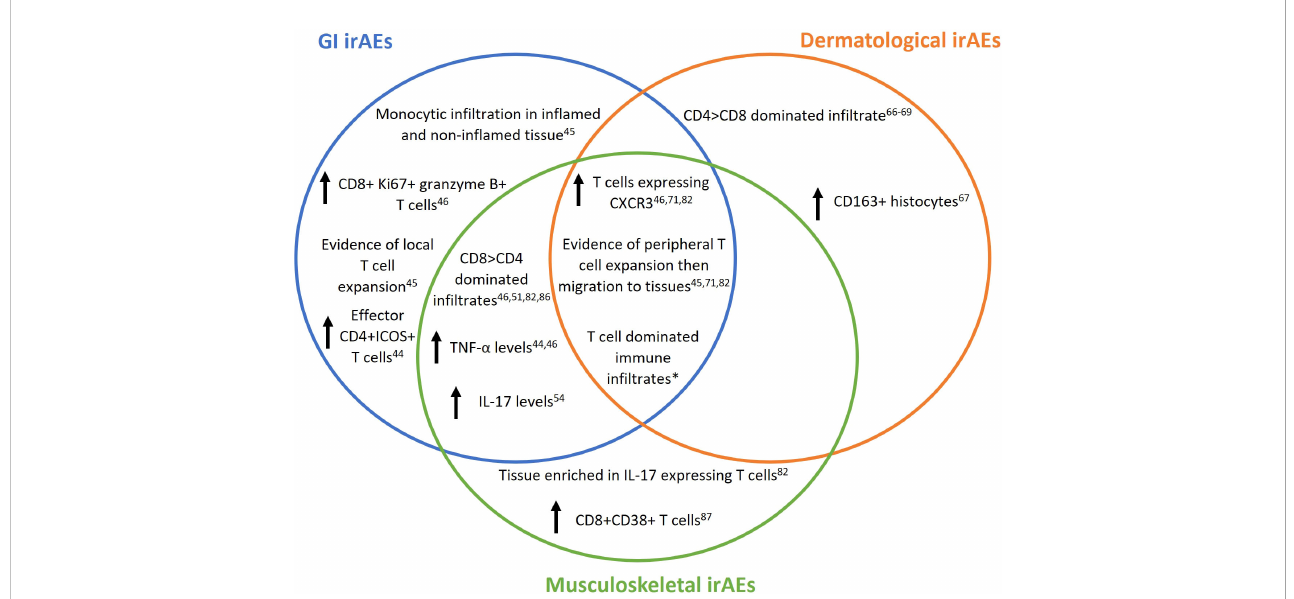
FIGURE 1 Reported immunological changes in patients on checkpoint inhibitor (CPI) therapy developing immune related adverse events (irAEs). IrAEs are common with CPI use and can affect multiple organs systems including but not limited to gut, skin and joints. Multiple risk factors may contribute to irAE development and/or their localisation to the represented tissues, including genetic variation, microbiome, pre-existing immune-mediated disease and stromal characteristics. Venn diagram depicts immune changes reported in human gut, skin and joint tissue following CPI therapy reported so far in the literature and covered by this review. *All research articles containing peripheral blood or tissue immune characterisation covered in this